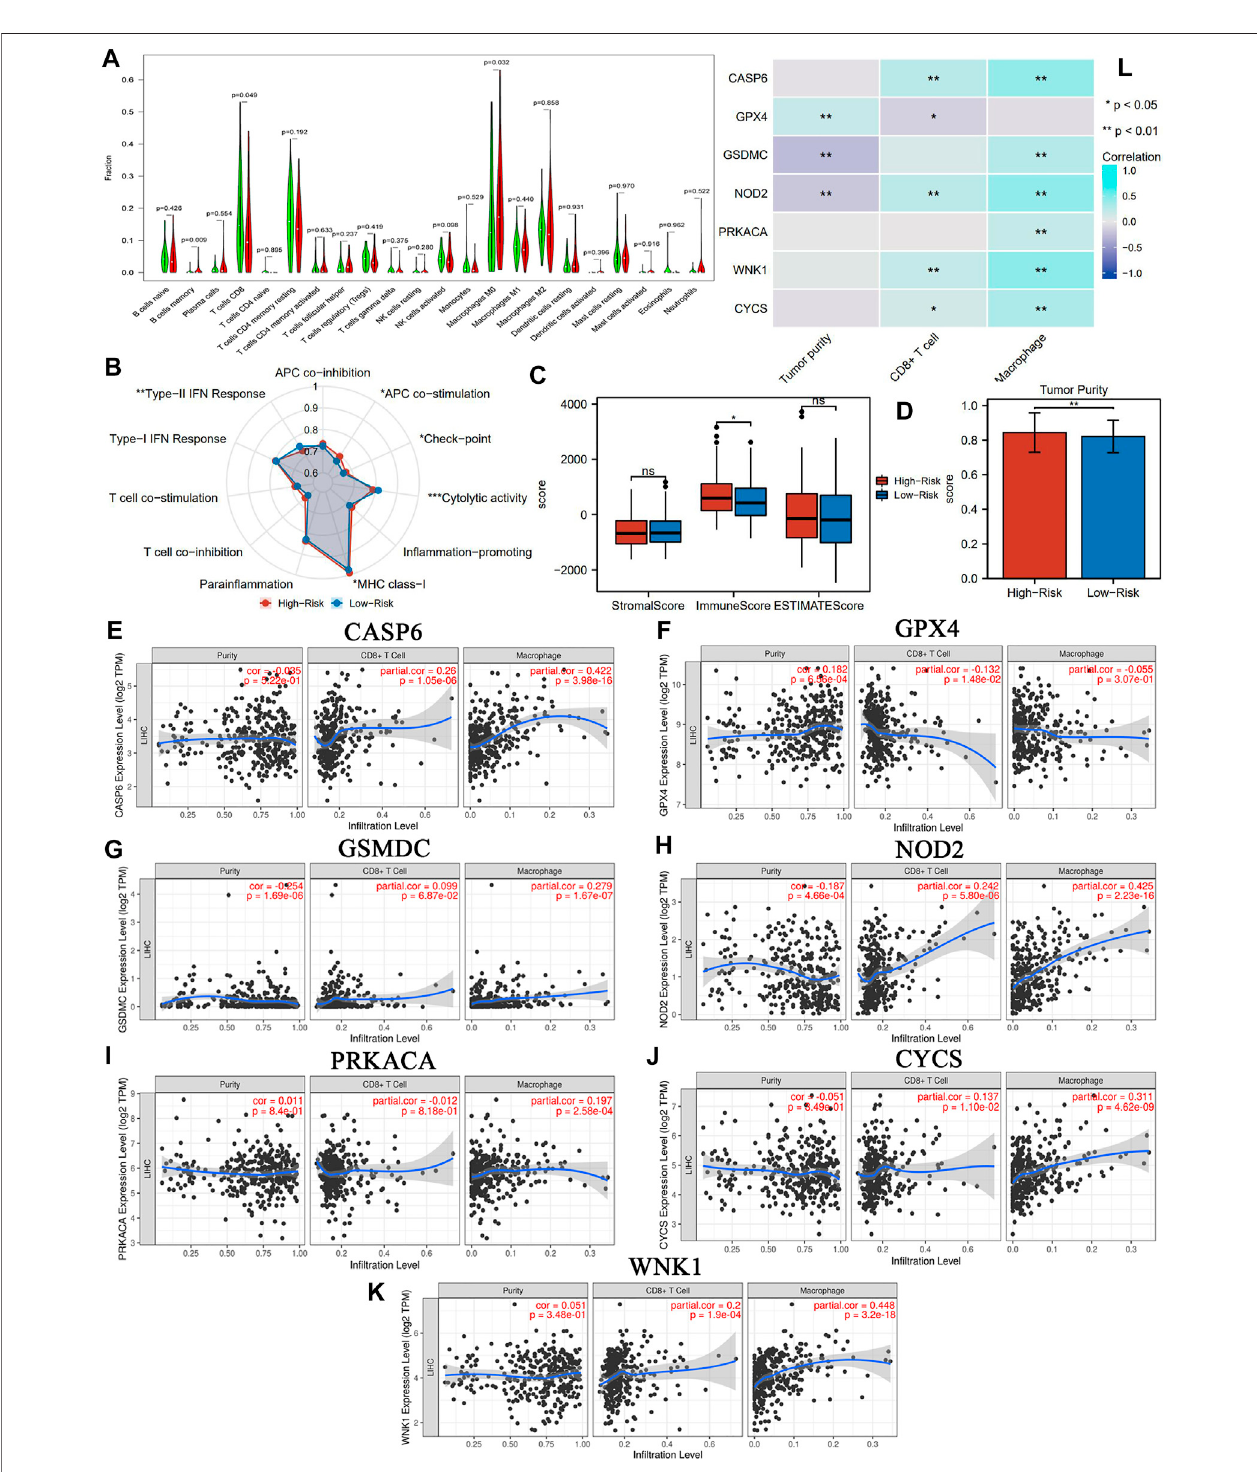
FIGURE 5 | PR risk score is closely associated with TIM (A) The distribution of the immune abundance of 22 leukocyte subtypes in each HCC sample. (B) The effects of PR risk level on the activities of 11 immune-related signaling pathways. (C) The differences in the stromal score, immune score, and ESTIMATE score. (D) The differencesintumorpurity. (E – K) ThecorrelationsbetweenPRriskscore,andthein fi ltrationlevelsofCD8 + TcellsandmacrophagesbasedonTIMER database. (L) The summary of immune correlations. PR, pyroptosis-related; TIM, tumor immune microenvironment; HCC, hepatocellular carcinoma; * p < 0.05, ** p < 0.01.